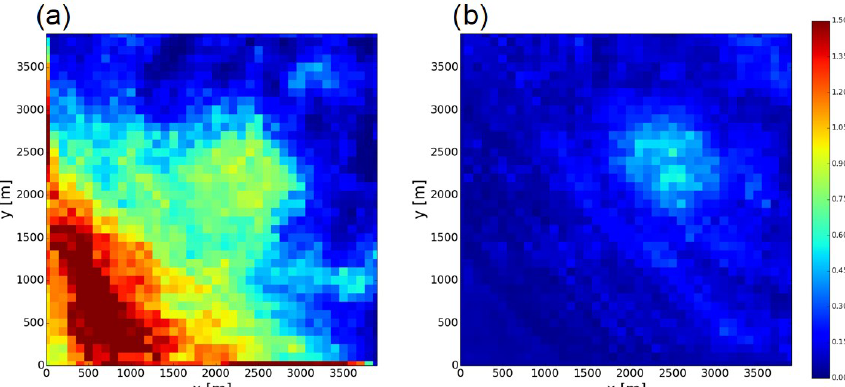
Figure 10. The Kullback–Leibler divergence of ensemble members generated by the (a) OF_NoDA and (b) noOF_NoDA experiments at t = 4